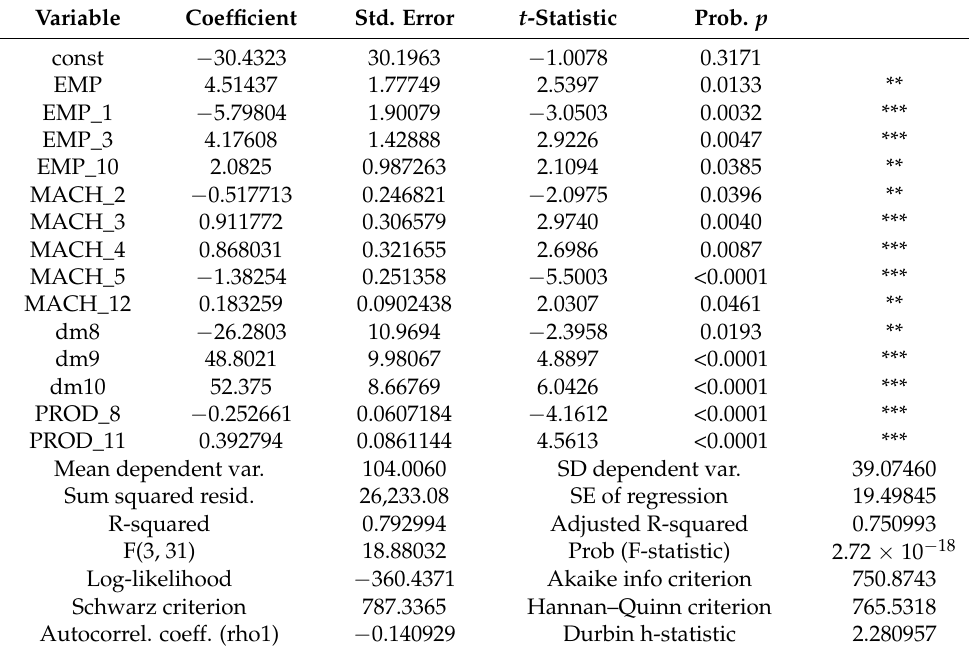
Table A2. Dependent variable: value of ready-made production (in sales prices) in period t (PROD) (observation 2001:01–2007:12 (N = 84)).